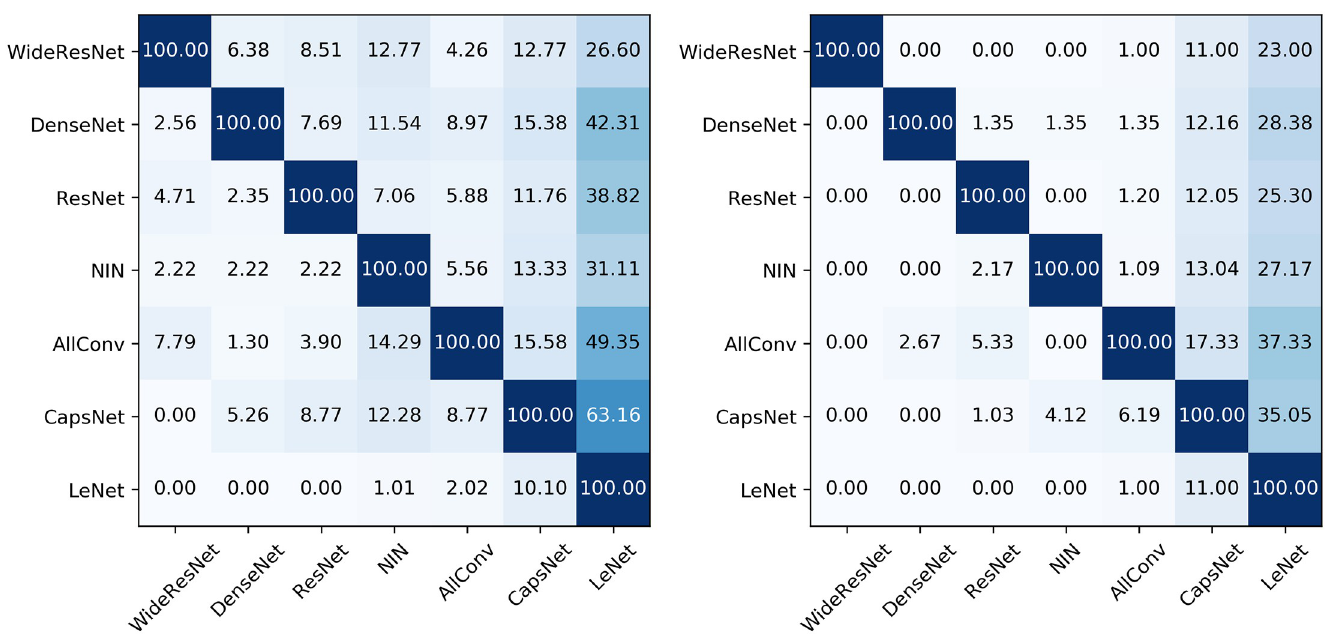
Fig 5. Transferability of adversarial samples. Accuracy of adversarial samples when transferring from the a given source model (row) to a target model (column) for both L 1 black-box Attacks (left) and L 0 black-box Attacks (right). The source of the adversarial samples is on the y-axis with the target model on the x-axis. The adversarial samples were acquired from 100 original images attacked with th varying mostly from one to ten. The maximum value of th is set to 127.